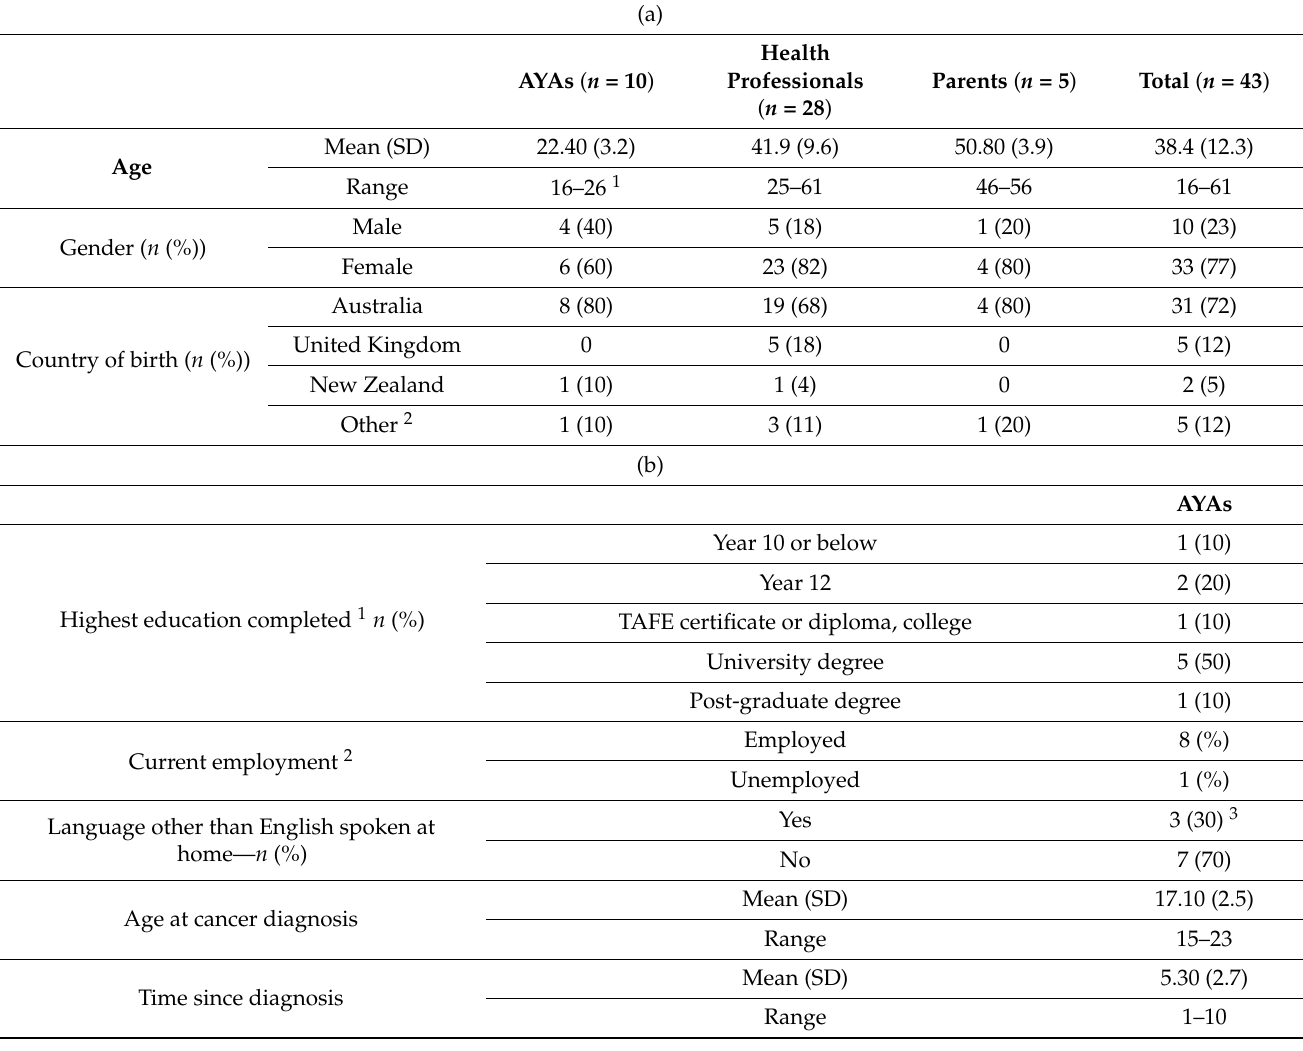
Table 2. (a) Participant demographics across all groups. (b) Socio-demographic and cancer charac- teristics of AYA participants ( n = 10). (c) Socio-demographic and cancer characteristics of parent participants ( n =